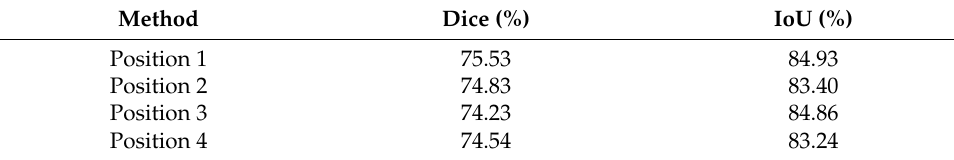
Table 3. Ablation experiments on the ISBI2017 dataset.